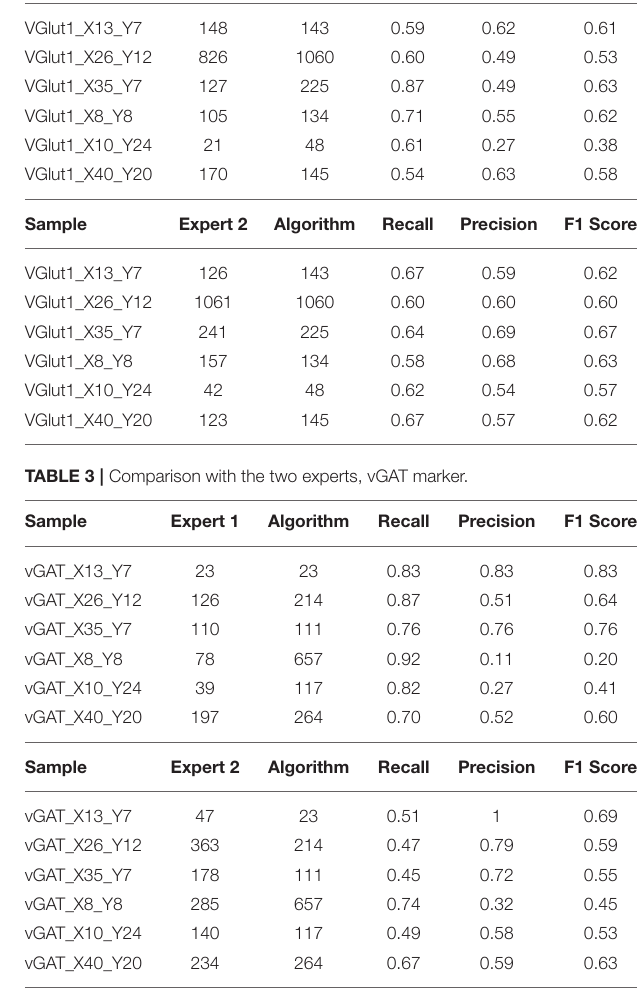
TABLE 1 | Parameters used in the vGlut-1 and vGat experiments. parameter